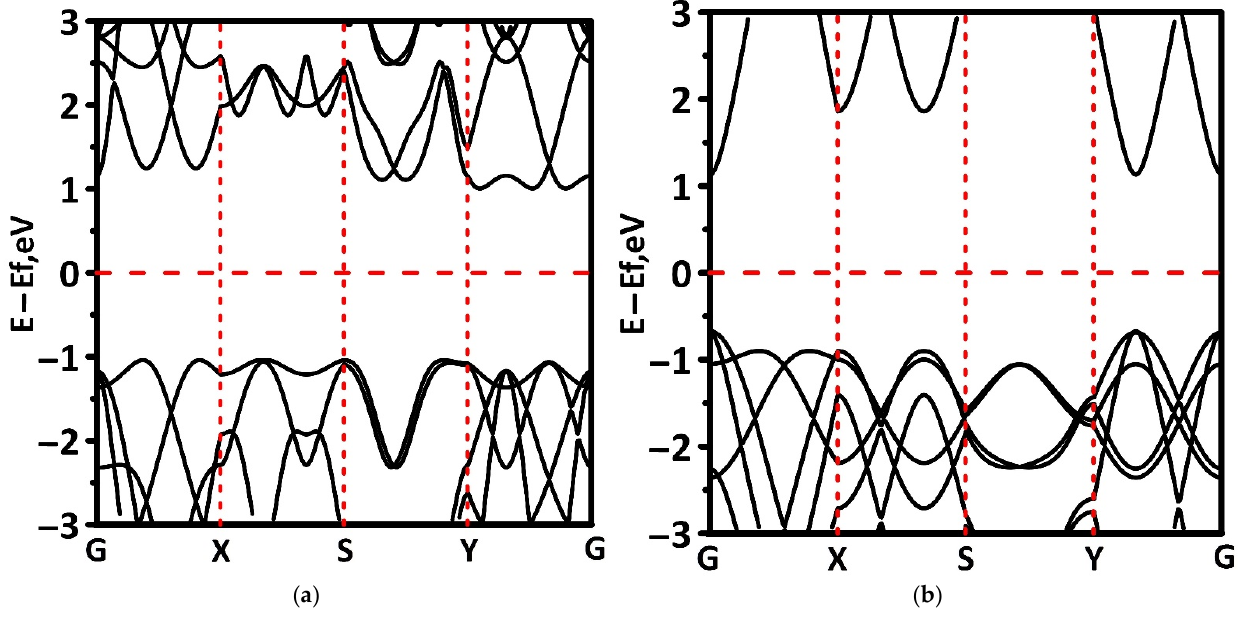
Figure 3. Band structure of BlueP ( a ) and ZnO ( b ) monolayers.